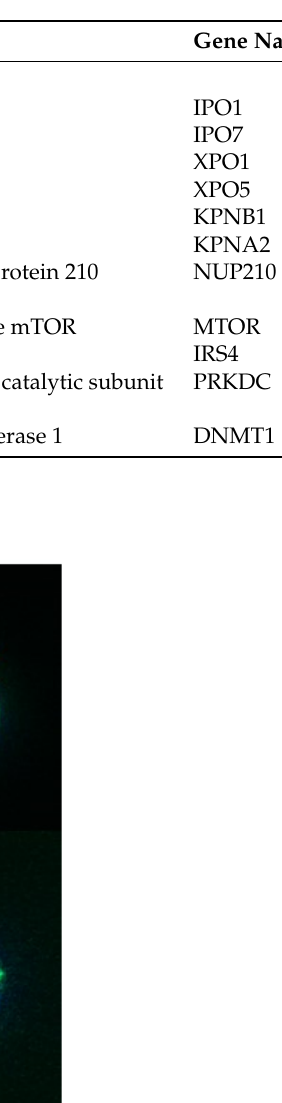
Table 1. List of GPR37L1-associated proteins detected by mass spectrometry.